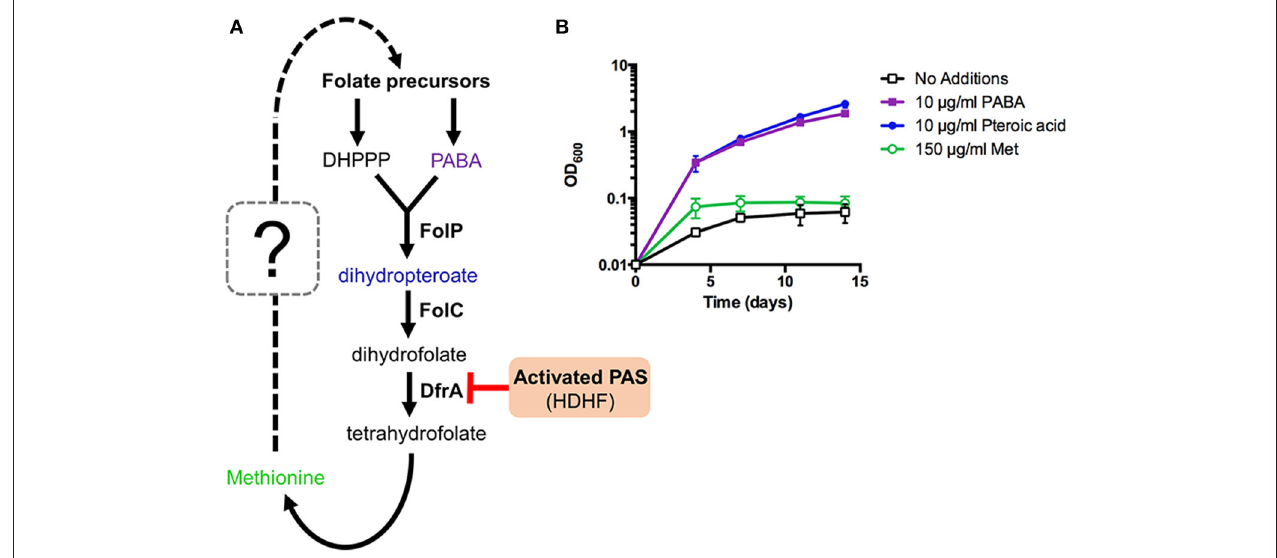
FIGURE 4 | Methionine can affect but not bypass essentiality of upstream folate biosynthetic pathways in M. tuberculosis . (A) New working model of methionine-mediated PAS antagonism. (B) M. tuberculosis 1 pabB was grown to an OD 600 of ∼ 0.5, washed three times with PABA-free 7H9 medium to remove residual PABA and resuspended in PABA-free 7H9 medium to a starting OD 600 of 0.01. Cultures were then supplemented with the indicated metabolites and incubated for 14 days with OD 600 readings taken at the given time points.